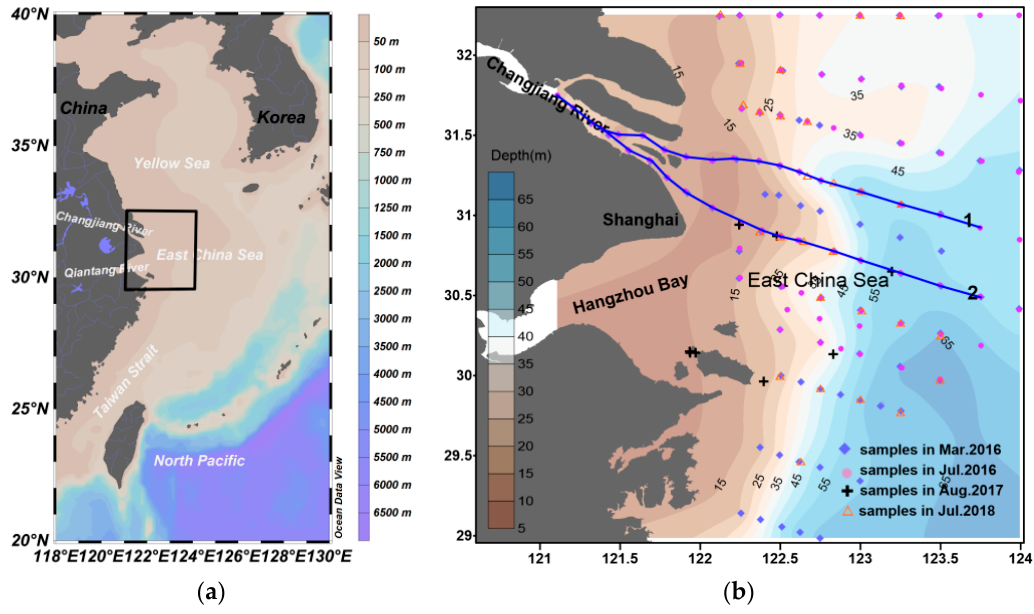
Figure 1 . ( a ) Location of the study area; ( b ) Detailed distribution of the samples during four cruises. Blue lines represent two transects selected for further analysis in later sections, transect 1 including section B and A4, and transect 2 including section C and A6.